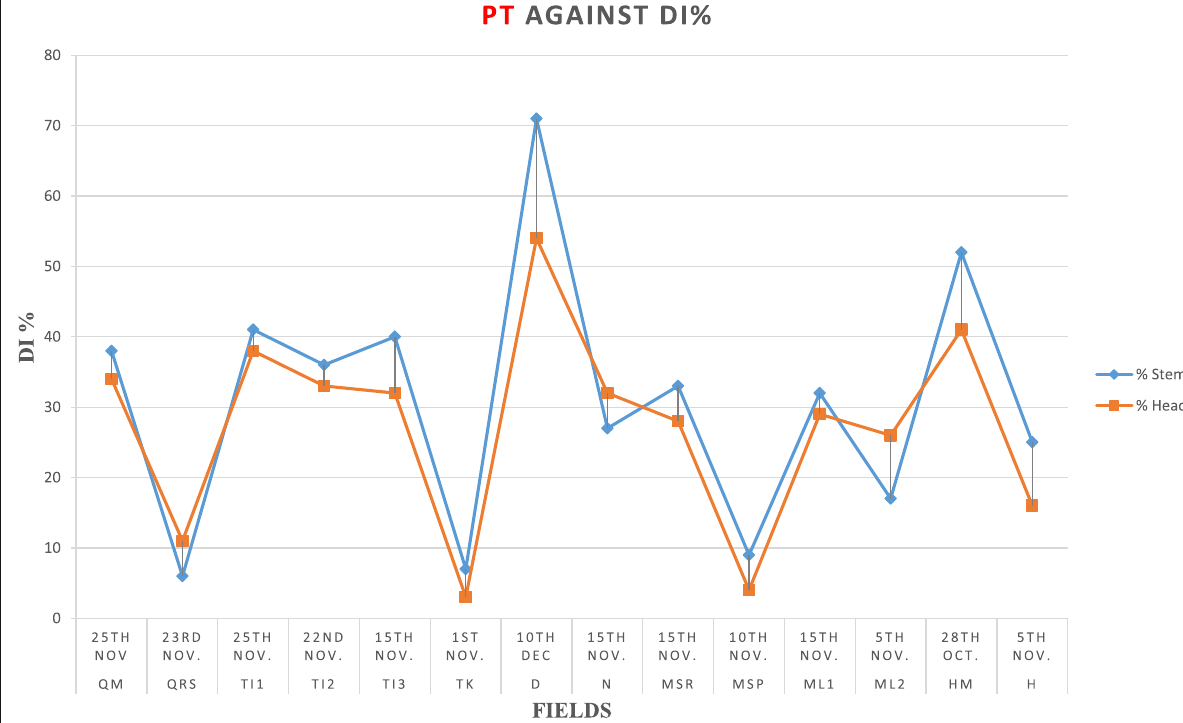
Fig. 2 The effect of planting time on disease incidence in plant head and stem in the 14 selected wheat fields in the south of Iraq/Basra